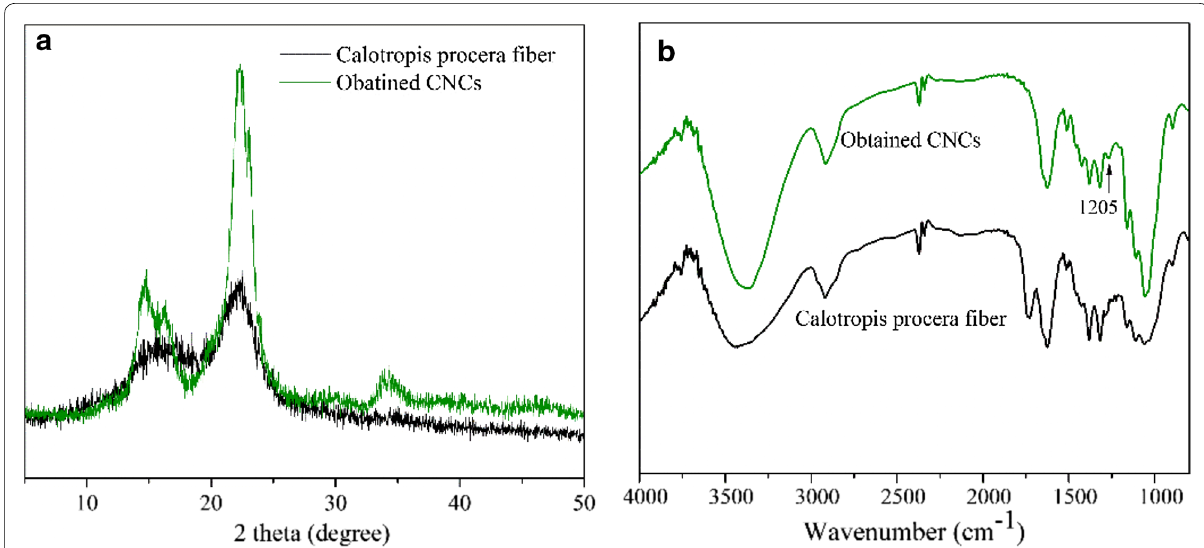
Fig. 6 XRD and FTIR analyses of Calotropis procera fiber and the obtained cellulose nanocrystal